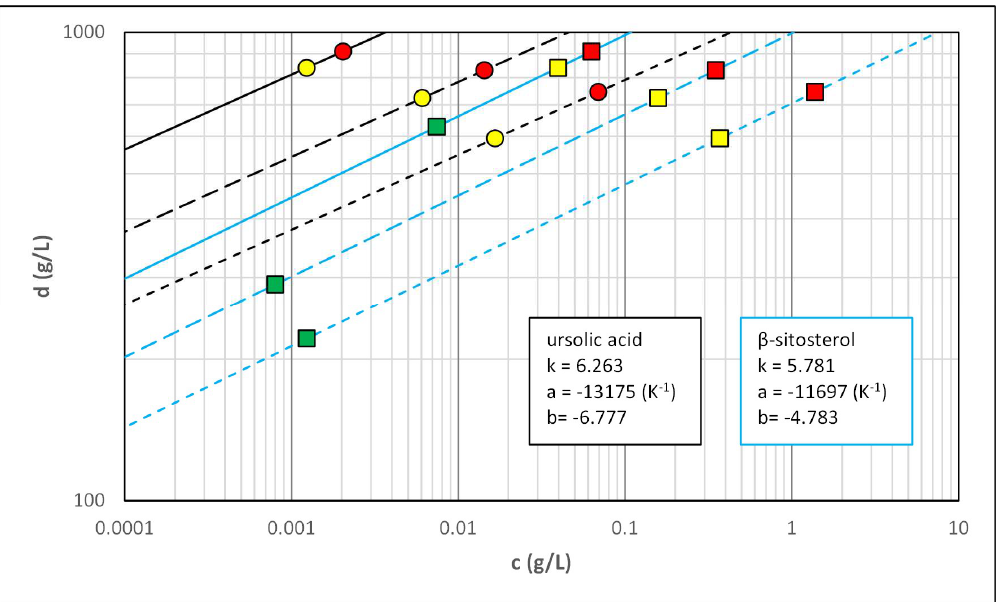
Figure 4. The application of Chrastil’s equation for the description of the solubility of ursolic acid and β-sitosterol in supercritical carbon dioxide. Symbols: black lines and circles—ursolic acid, blue lines and squares—β-sitosterol, solid lines—40 °C, long-dashed lines—60 °C, short-dashed lines—80 °C, green markers—10 MPa, yellow markers—20 MPa, red markers—30 MPa.